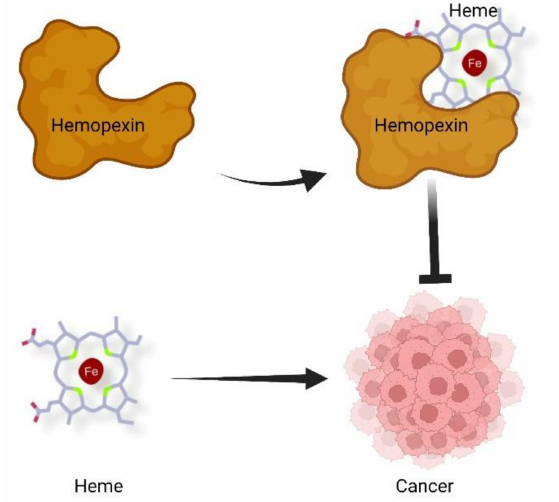
Figure 1. Proposed contribution of heme and Hx to cancer development. According to this model, heme sustains cancer growth and progression, whereas Hx, by scavenging heme, counteracts tumor growth and dissemination. Figure created with BioRender.com, 10 December